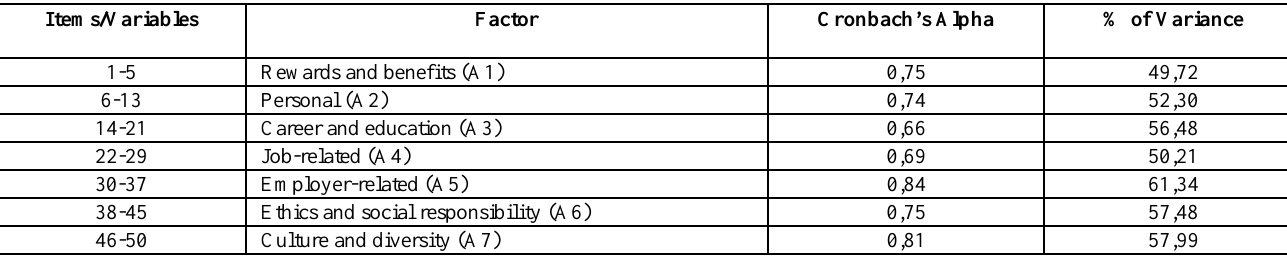
Table 2: Cronbach’s alpha for Section A of the questionnaire